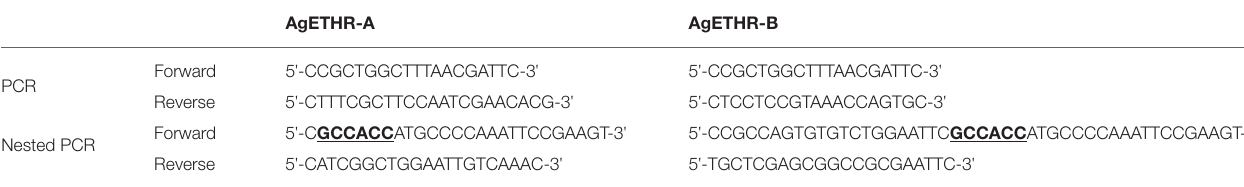
TABLE 1 | Details of primers used in the